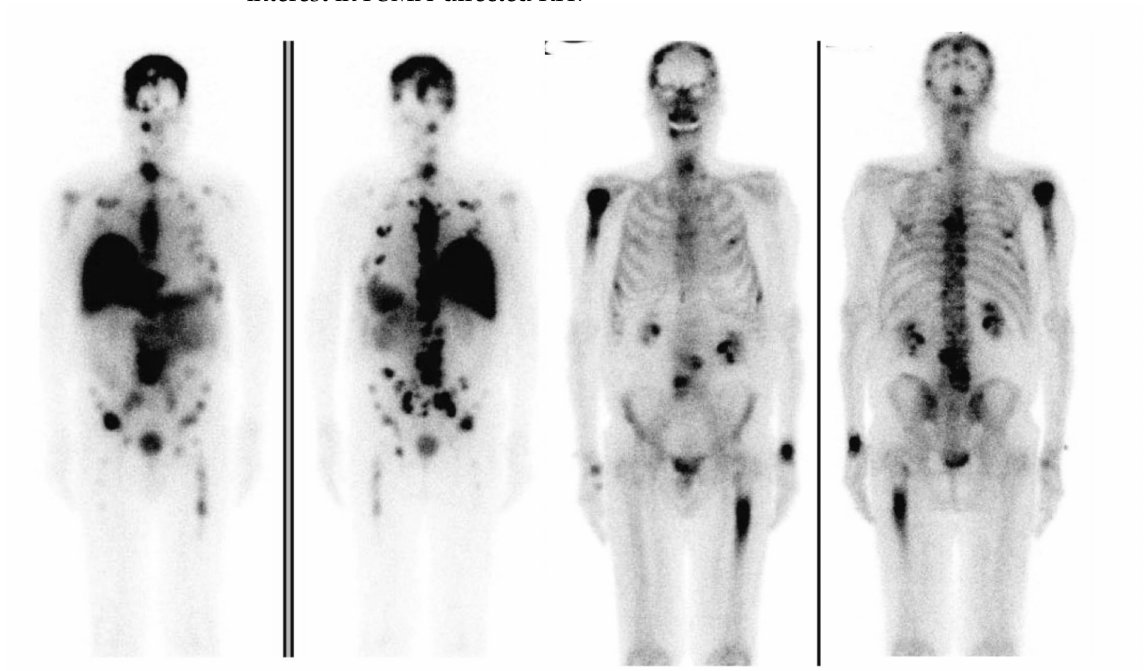
Figure 3. Left to right: 177 Lu-J591 anterior and posterior whole-body images 7 days after 177 Lu- J591 administration, and Technetium 99m-methyl diphosphonate ( 99m Tc-MDP) bone scan anterior and posterior whole-body images, showing 177 Lu-J591 targeting of extensive bone and soft-tissue metastases. Reprinted with permission from: Tagawa S.T, et al. Phase 1/2 Study of Fractionated Dose Lutetium-177–Labeled Anti–Prostate-Specific Membrane Antigen Monoclonal Antibody J591 ( 177 Lu-J591) for Metastatic Castration-Resistant Prostate Cancer. Cancer, 2019 Aug 1; 125 (15): 2561– 2569